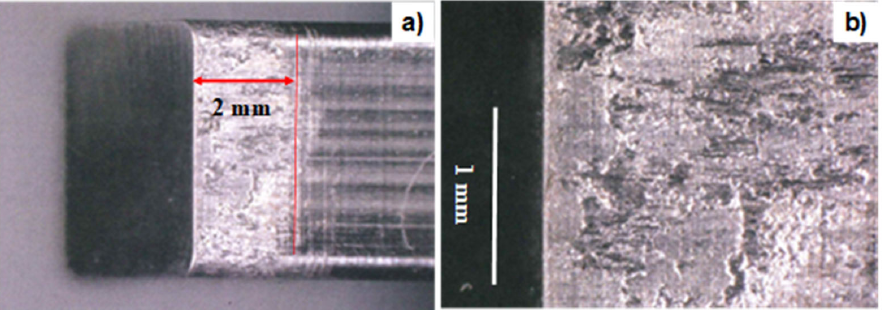
Figure 4. The bare YXR7 punch just after fine blanking a pure titanium plate with a thickness of 2 mm in a single shot: ( a ) overview of the bare YXR7 punch and ( b ) XYR7 punch side surface with severe adherence of titanium fragments.